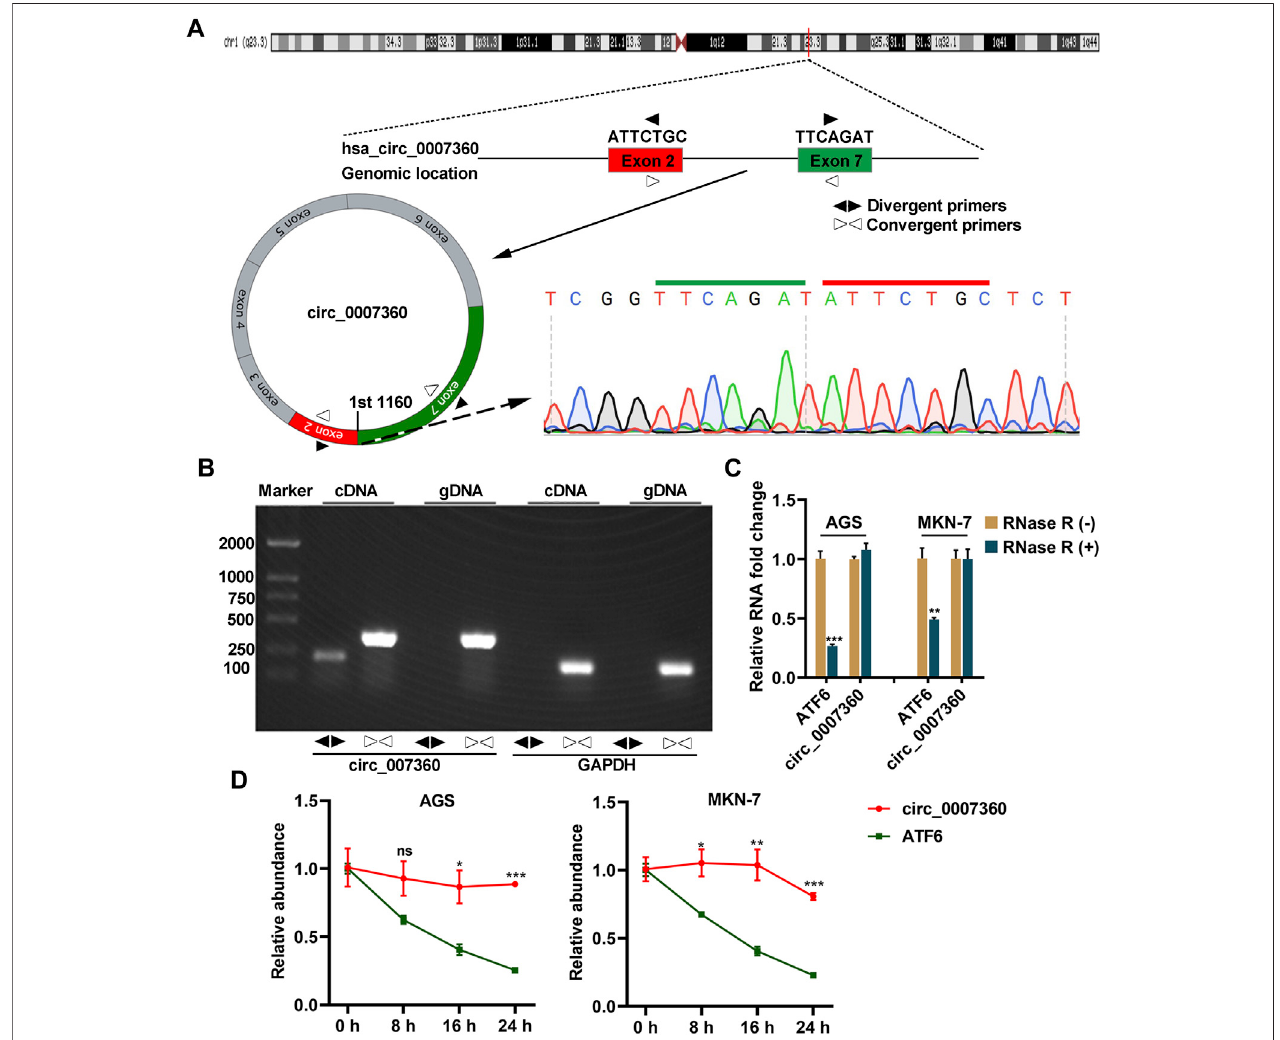
FIGURE 1 | Circ0007360 is a circular RNA. (A) A schematic model showing the genomic locus of circ0007360 , the location of divergent and convergent primer pairs used for detecting circ0007360 expression, as well as the sanger sequencing result of the junction site. (B) The DNA gel result for detecting the PCR products ampli fi ed by the indicated primers for circ0007360 or GAPDH . (C) RT-qPCR quanti fi cation of the RNA levels of ATF6 or circ007360 with or without RNase R treatment. (D) RT-qPCR quanti fi cation of the RNA levels of ATF6 or circ007360 with or without actinomycin D treatment for the indicated time points.